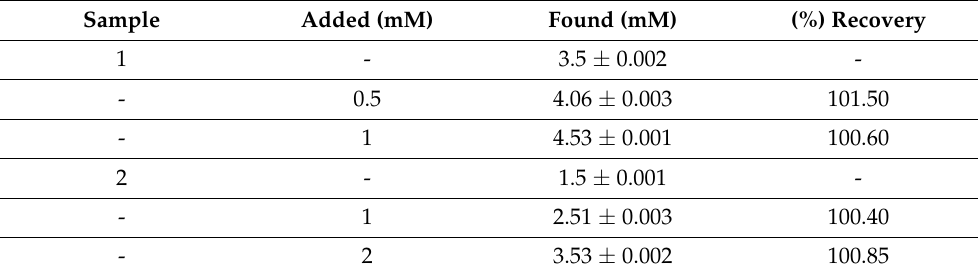
Table 6. Wheat sample analysis using % recovery method for the detection of urea.